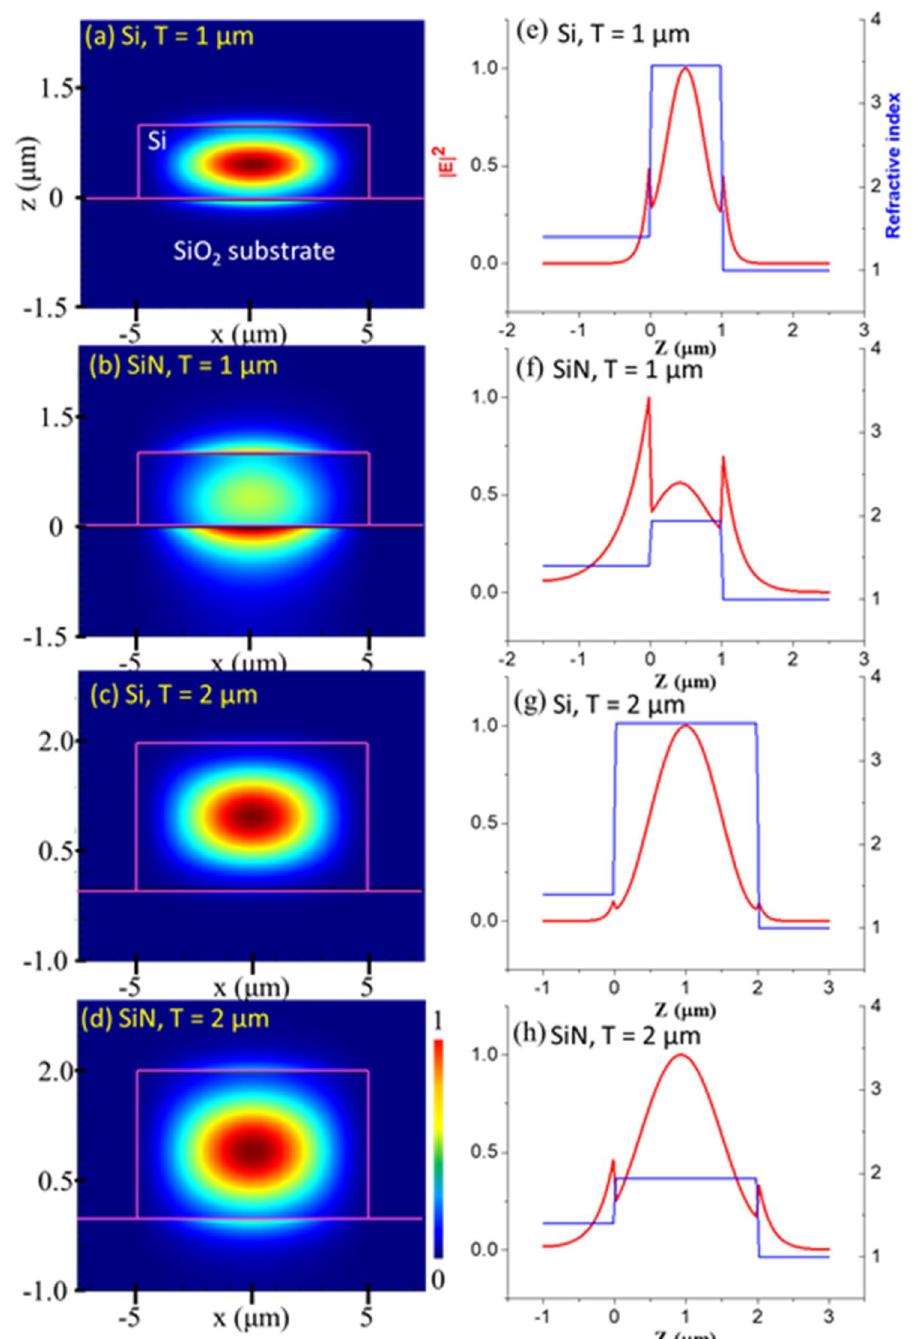
Figure 4. ( a – d ) Simulated 2-D waveguide modes and ( e – h ) 1-D intensity profiles along the z-axis for thicknesses T = 1 and 2 µm for the Si and SiN waveguides, respectively. TM polarization was selected for the waveguide